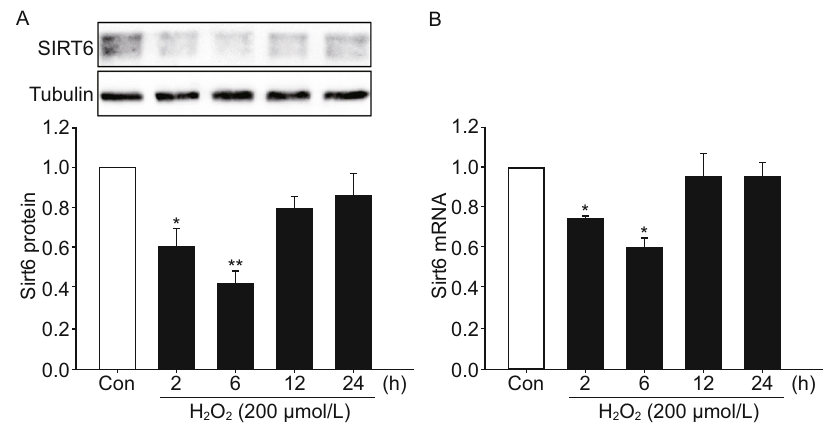
Figure 1. SIRT6 expression after H 2 O 2 treatment. SH-SY5Y cells were exposed to 200 µmol/L H 2 O 2 for 1 h and then cultured for indicated time. SIRT6 protein (A) and mRNA (B) levels were detected by Western blot and qPCR. Bars represent the mean ± SEM from three independent experiments. * P < 0.05; ** P < 0.01, compared with the control